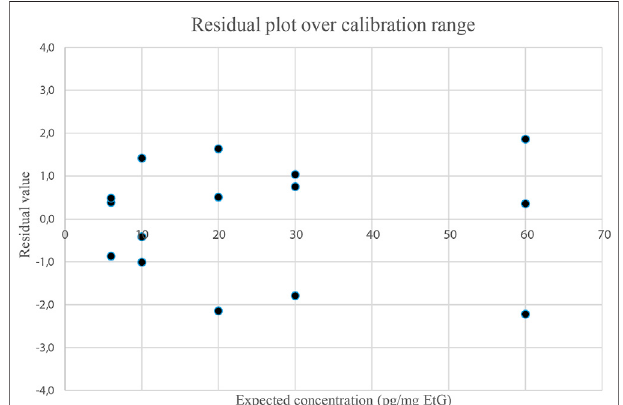
FIGURE 3 | Residue plot of calibration points (3 replicates per level) calculated by subtracting from the expected value the concentration obtained with the curve. Residue values were then plotted against the expected concentration.